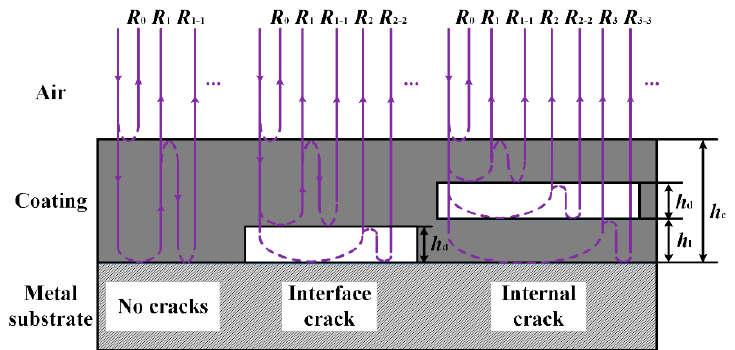
Figure 4. Schematic diagram of terahertz wave reflection propagation in the coating system.